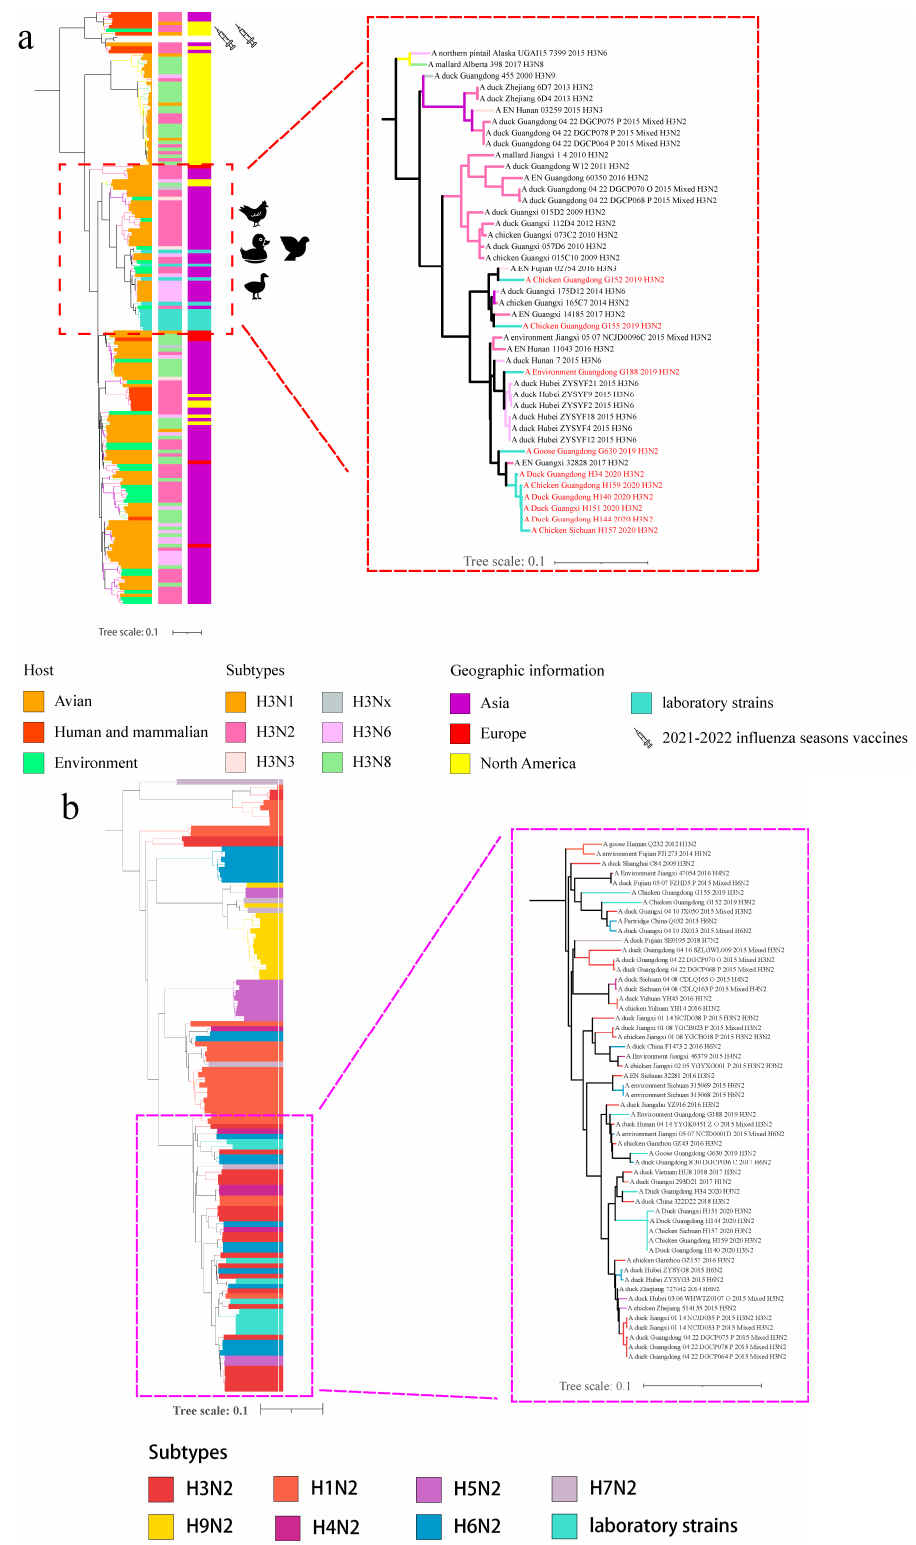
Figure 1. Phylogenetic analysis of HA gene of H3Ny and NA genes of H X N2 subtypes. Phylogenetic tree of ( a ) HA gene of H3Ny AIVs; ( b ) N2 gene of HxN2 AIVs. Phylogenetic analysis was performed three times using the maximum likelihood (ML) method in IQ-TREE under the GTR + F + G4